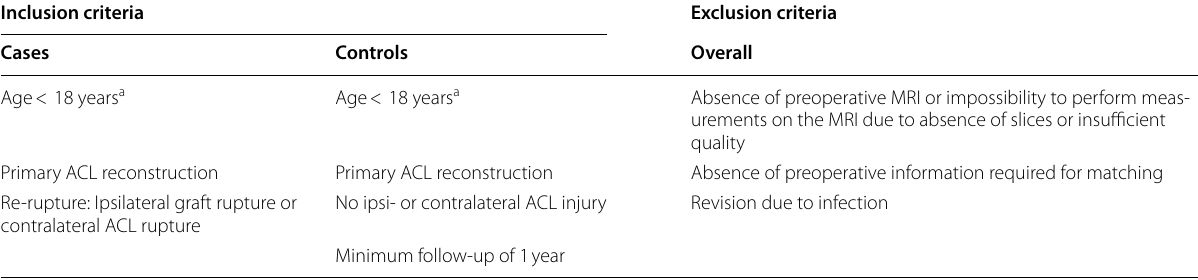
a < 18 years at time of primary ACL reconstruction